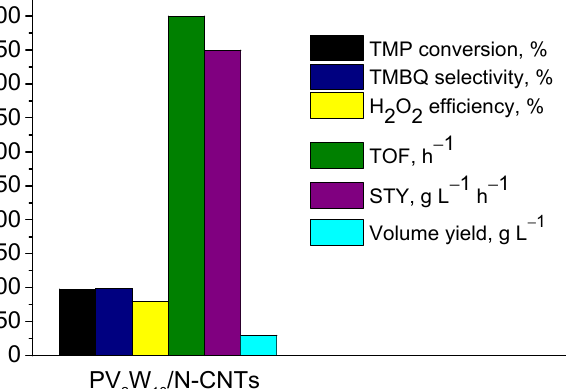
Figure 11. Catalytic characteristics of PV 2 W 10 /N-CNTs in TMP oxidation to TMBQ with H 2 O 2 . (STY: space-time yield). Adapted with permission from ref. [100] Evtushok et al. Highly efficient catalysts based on divanadium-substituted polyoxometalate and N-doped carbon nanotubes for selective oxidation of alkylphenols ACS Catalysis 2018 , 8 , 1297–1307. Copyright 2018 American Chemical Society.